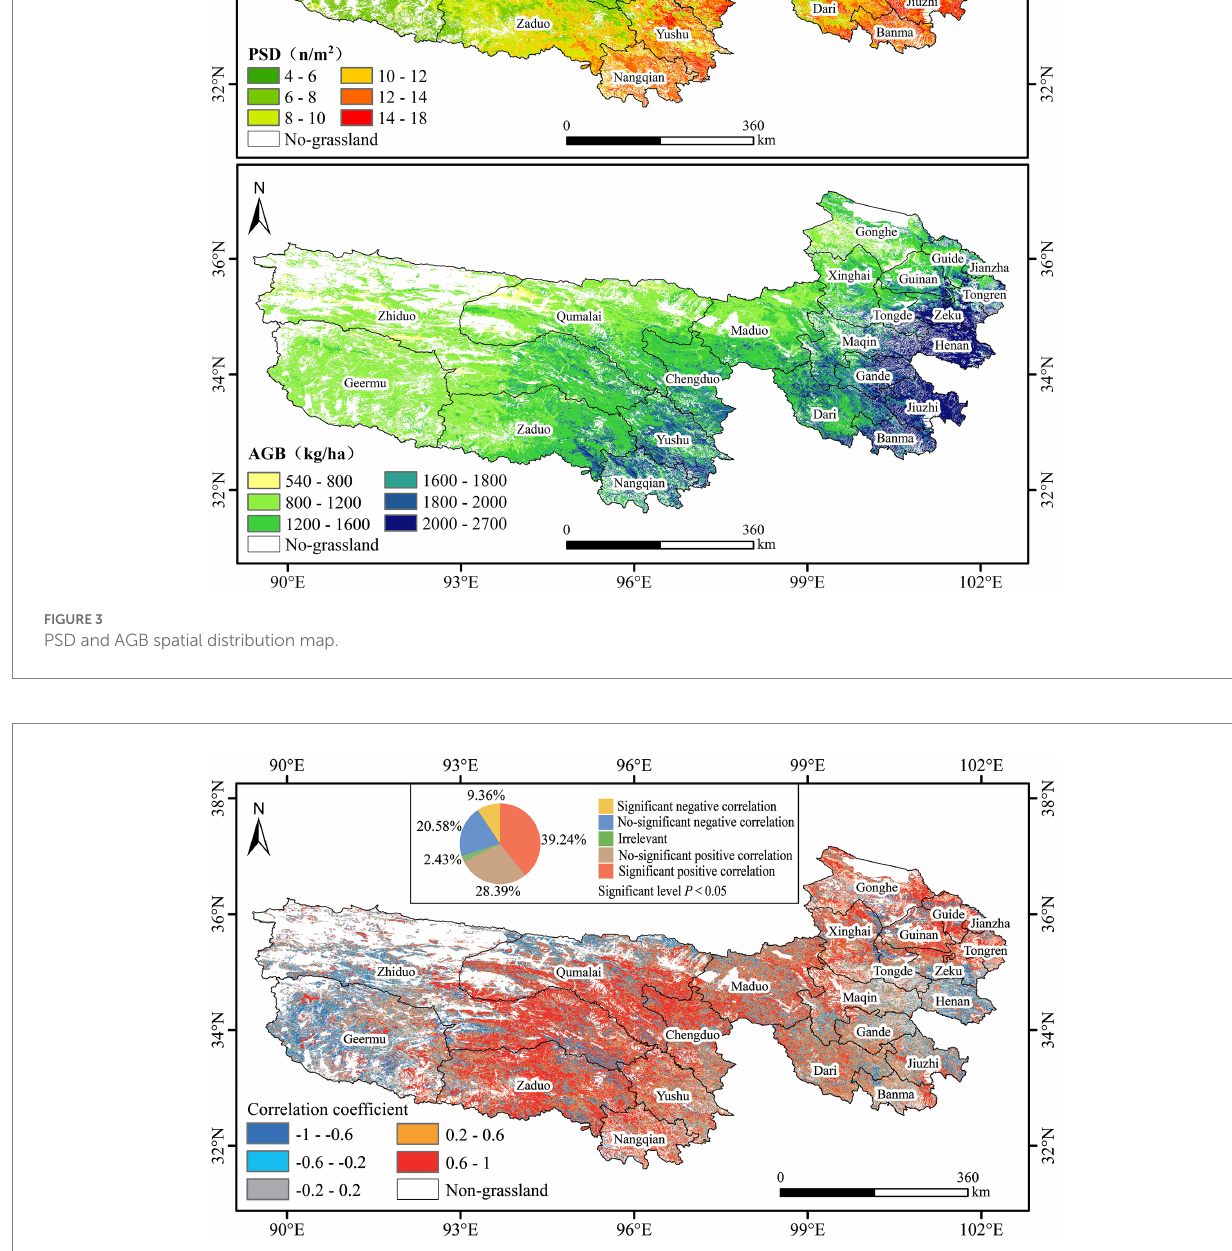
FIGURE 4 Spatial variation in the PSD–AGB